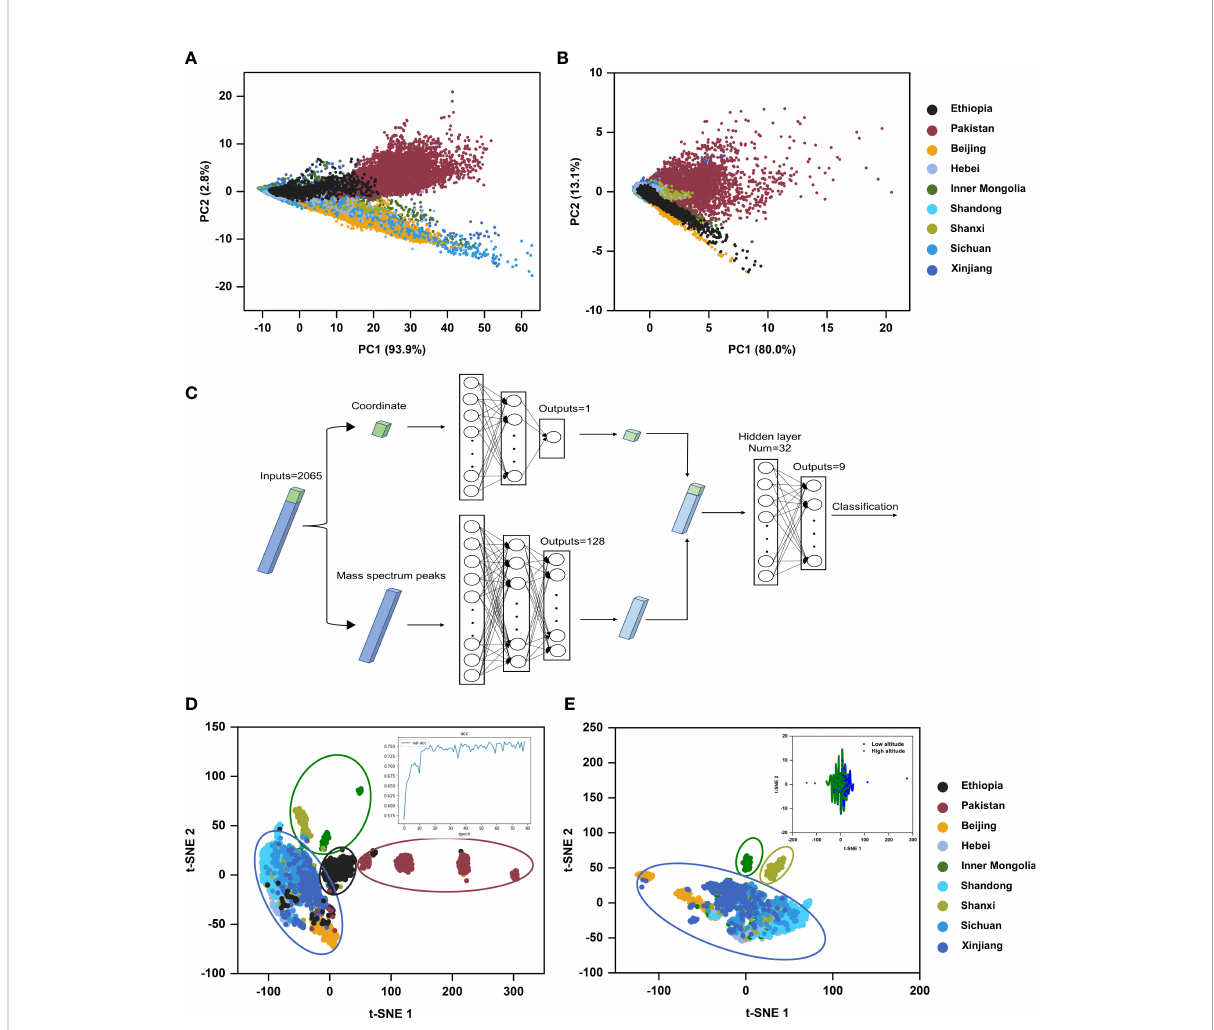
FIGURE 7 Multivariate statistical analysis results of castor beans from different geographical sources. (A) Score plot of the MSI dataset of all mass spectra peaks in PCA model; (B) Score plot of the MSI dataset of the mass spectra peaks of RCBs in PCA model; (C) Schematic diagram of DNN model; (D) t-SNE visual scatter plot of DNN model based on MSI dataset from nine geographical sources, the inset was the accuracy rate curve of neural network; (E) t-SNE plot of DNN model based on MSI dataset from seven geographical sources in China, the inset was a t-SNE plot of DNN model based on MSI dataset from different